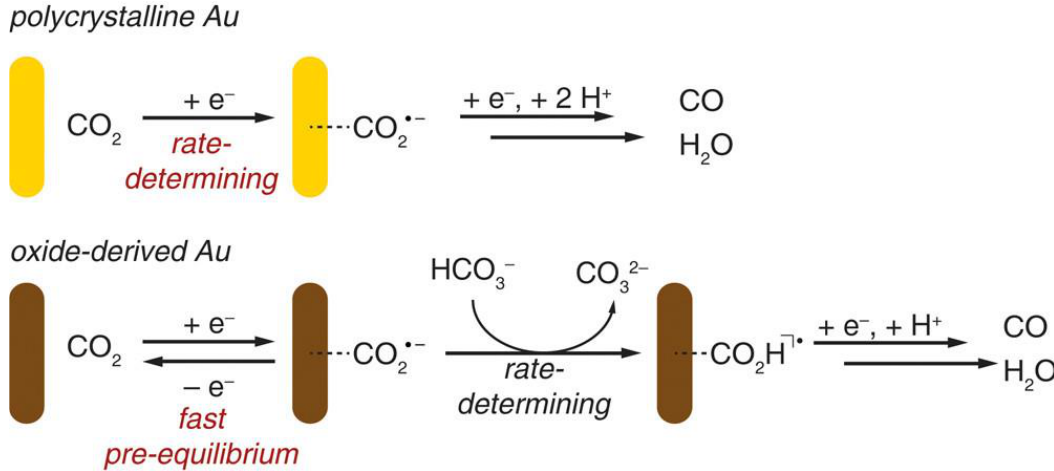
Figure 7. Proposed mechanisms for CO 2 reduction to CO on polycrystalline Au and oxide-derived Au. Reprinted from Ref. [112], copyright (2012), with permission from the American Chemical Society.